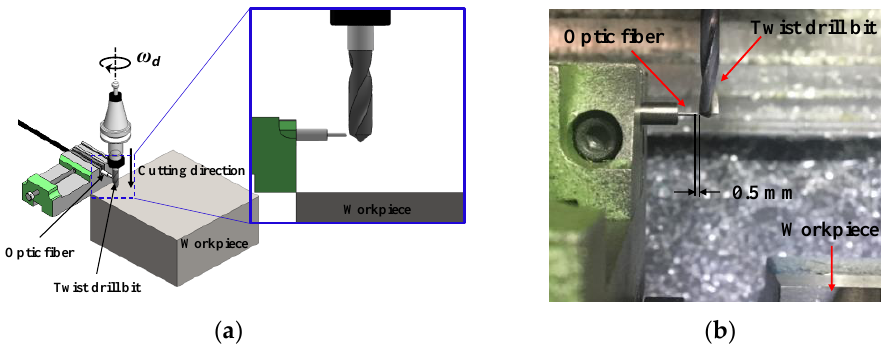
Figure 3. Experimental setup: ( a ) schematic, and ( b ) photograph. Table 3. Characteristics of infrared emitter and detector used in the experiments.